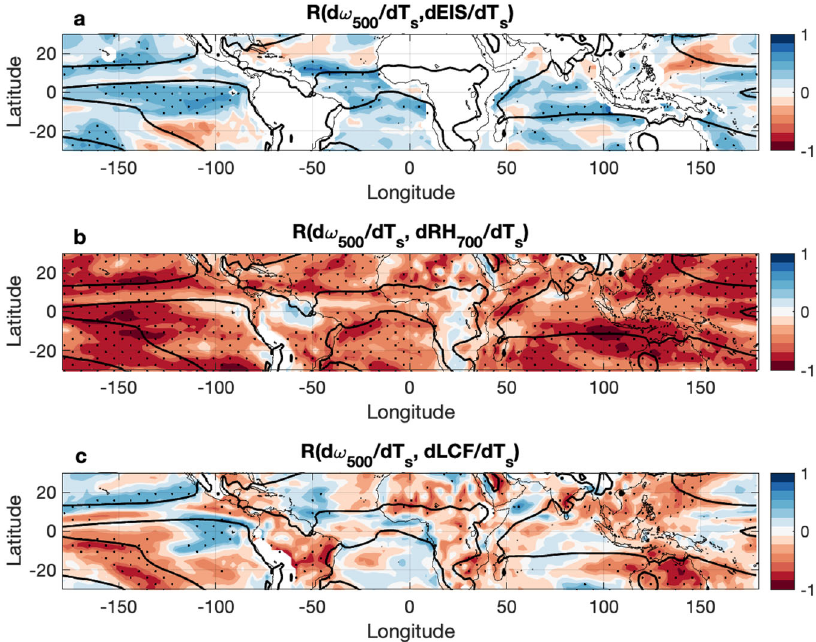
Fig. 5 | Low cloud fraction decreases most closely correspond to a lesser reductionofsubsidencealong convectivemargins where a resulting drierfree troposphere may disfavor low cloudiness through entrainment drying. The local Pearsoncorrelation coef fi cients between ( a ) changes to the pressurevelocity at 500 hPa (d ω 500 /dT s ; hPa day − 1 K − 1 ) and changes in the estimated inversion